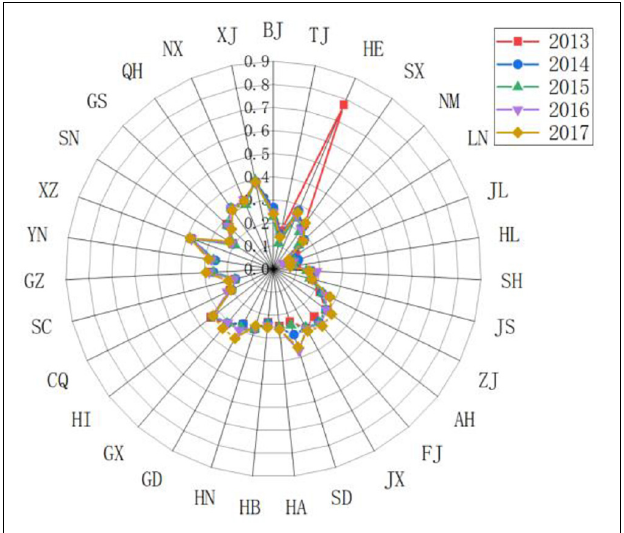
FIGURE 6 | Comparing the scores of the development of the sport resilience influence subsystem in various provinces in China.